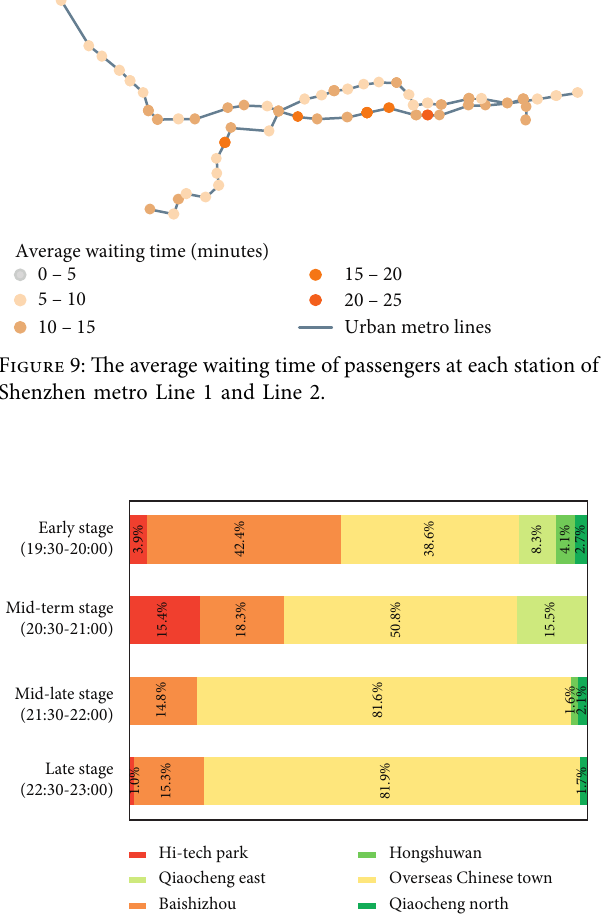
Figure 10: The proportion of the number of pedestrians departing from an alternative station to the total number of pedestrians at different stages of the crowding event.